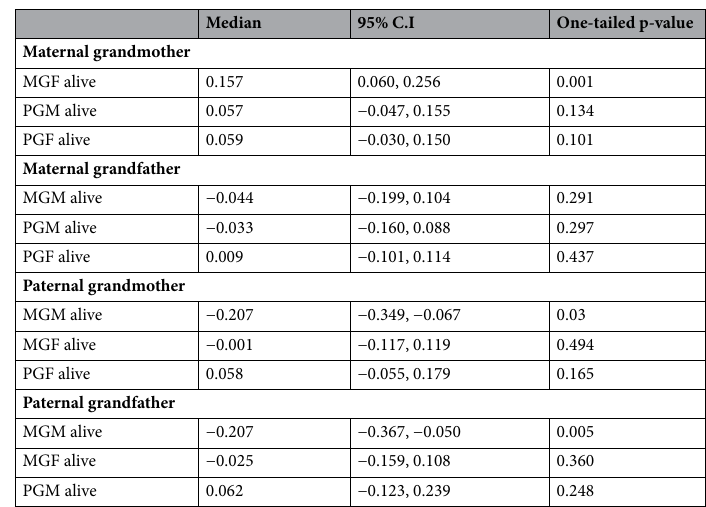
Table 1. Structural regression coefficients of a Bayesian structural equation model on how the survival status of maternal grandmothers (MGM alive; dead as a reference class) and grandfathers (MGF alive) as well as paternal grandmothers (PGM alive) and grandfathers (PGF alive) influenced each other’s investment in grandchildren. For full results, please see the supplementary material Table S3. For a positive posterior median, one-tailed p-value gives the proportion of posterior distribution that is below zero, and for a negative posterior median the proportion of posterior distribution that is above zero is given. 95% C.I. 95% credibility interval of the posterior median of